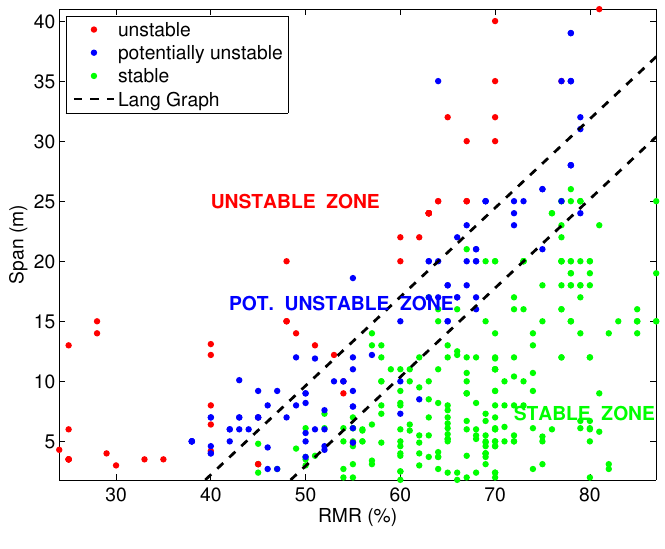
Figure 1. Critical span graph: B. Lang